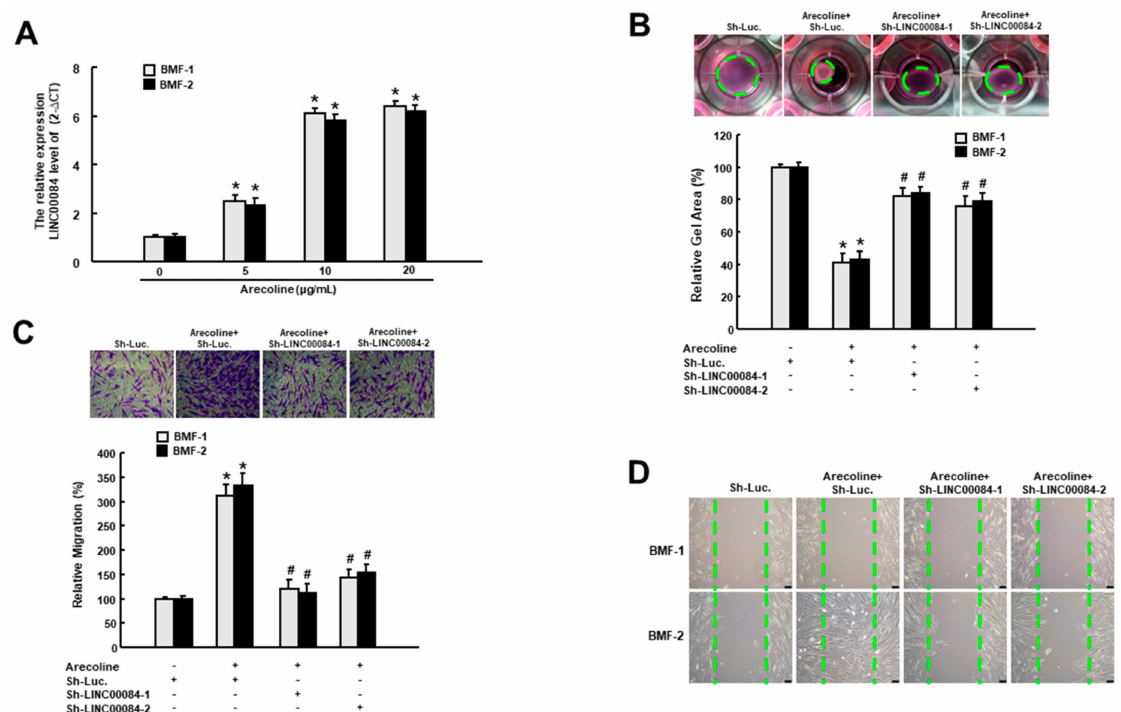
Figure 1. The arecoline-elicited LINC00084 mediates the myofibroblast activation. ( A ) The relative gene expression of LINC00084 in two buccal mucosal fibroblasts (BMFs) in response to the indicated concentration of arecoline. * p < 0.05 compared to control group (no arecoline); the arecoline-induced myofibroblast activities, including the enhanced collagen gel contraction ( B ), transwell migration ( C ), and wound healing capacities ( D ) were measured in arecoline-treated BMFs transfected with sh-LINC00084. Results are means ± SD of triplicate samples from three experiments. * p < 0.05 compared to Sh-Luc. group. # p < 0.05 compared to the arecoline + Sh-Luc.